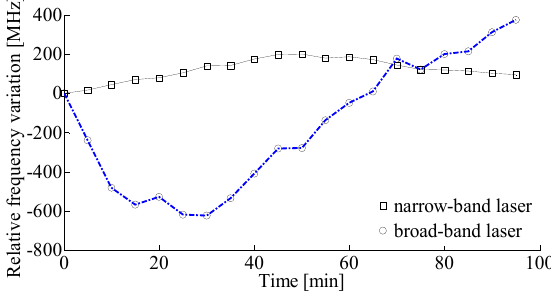
Figure 1. Relative frequency variations of the two laser sources.